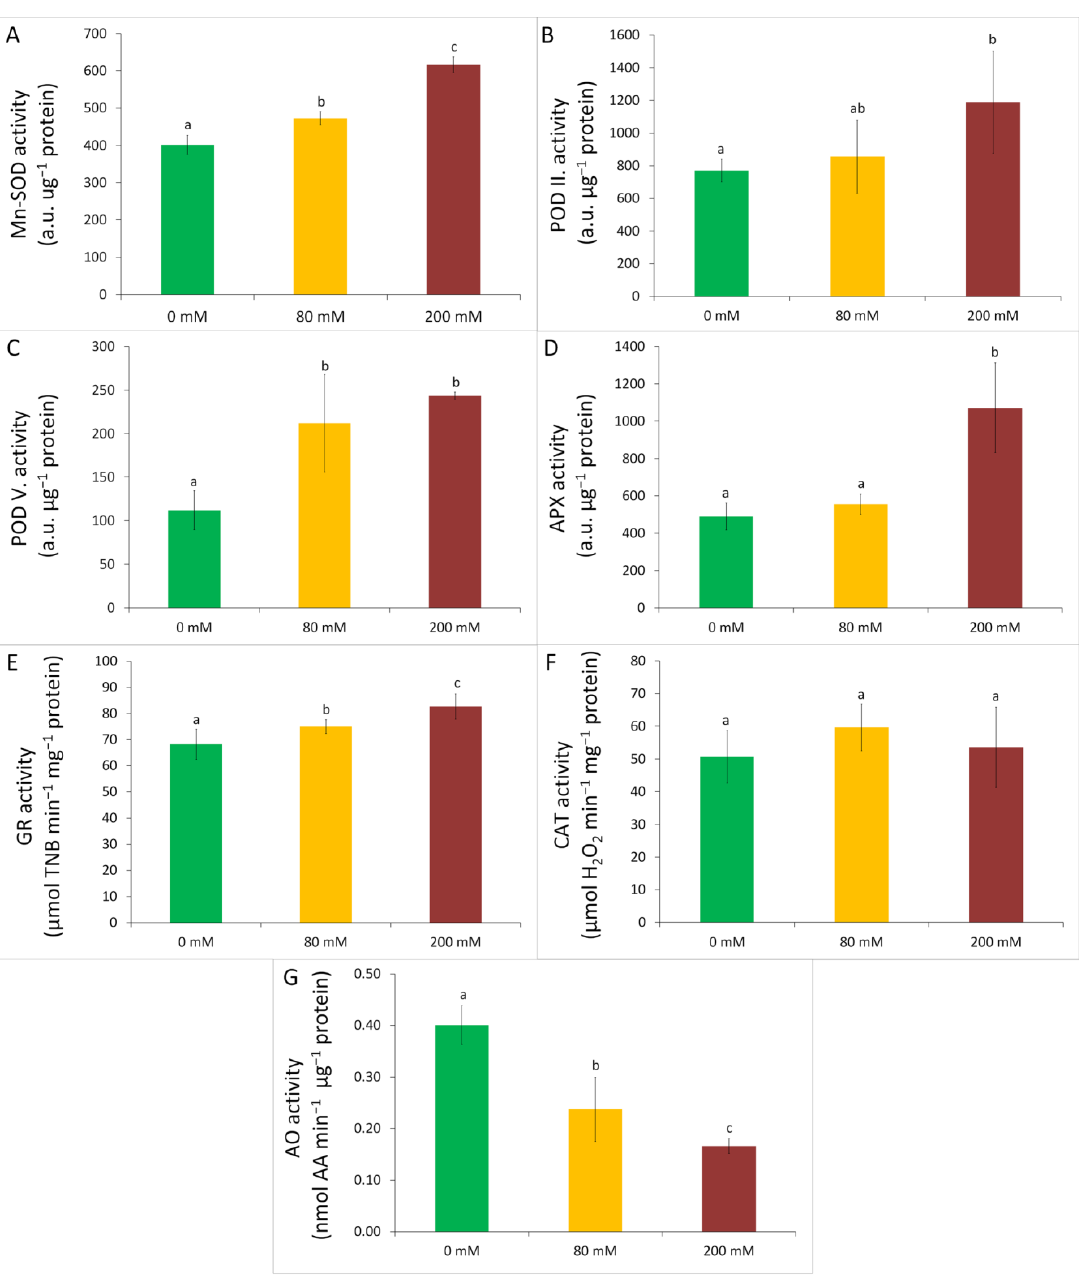
Figure 8. Mn-superoxide dismutase (SOD: A ), class III peroxidases (POD II : B ; POD V : C ), ascorbate peroxidase (APX: D ), glutathione reductase (GR: E ), catalase (CAT: F ), and ascorbate oxidase (AO: G ) activities in Arundo donax leaves after 1 month of alkaline salt treatment. Error bars represent SD values. To compare the differences, one- way ANOVA was performed on each dataset with Tukey’s post-hoc test on the treatments ( p < 0.05). Different lowercase letters indicate significantly different groups.